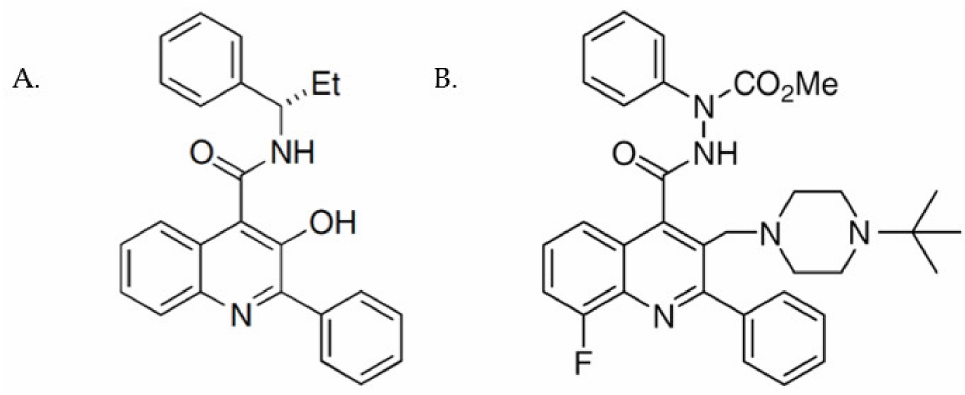
Figure 1. Chemical structures of NK3R antagonists. Chemical structures of the phenylquinoline-based NK3R antagonists talnetant ( A ) and M8 ( B